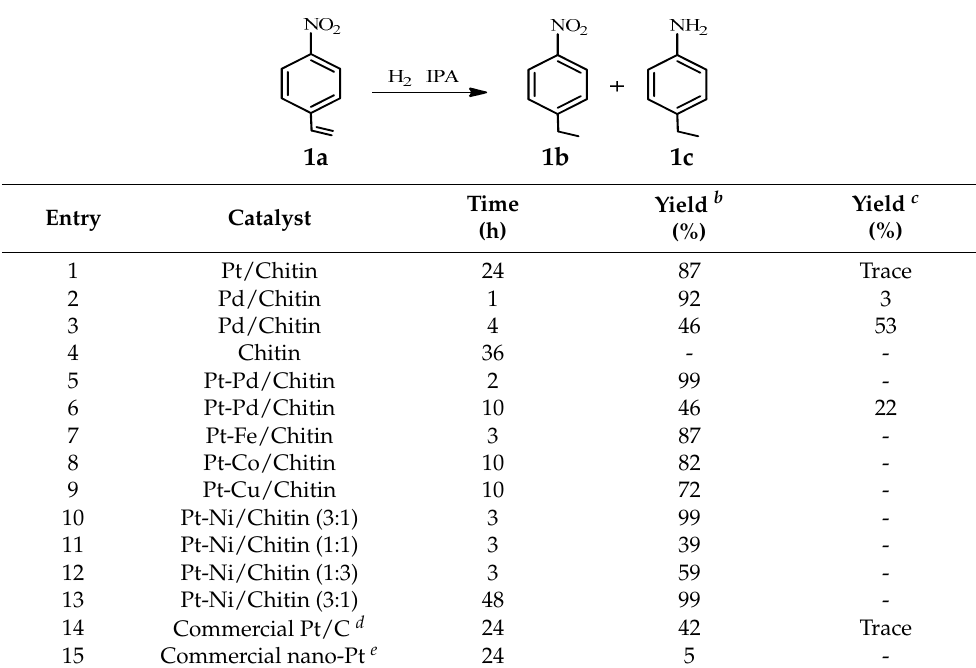
Table 1. Selective hydrogenation of C=C to C-C for 4-nitrostyrene a .